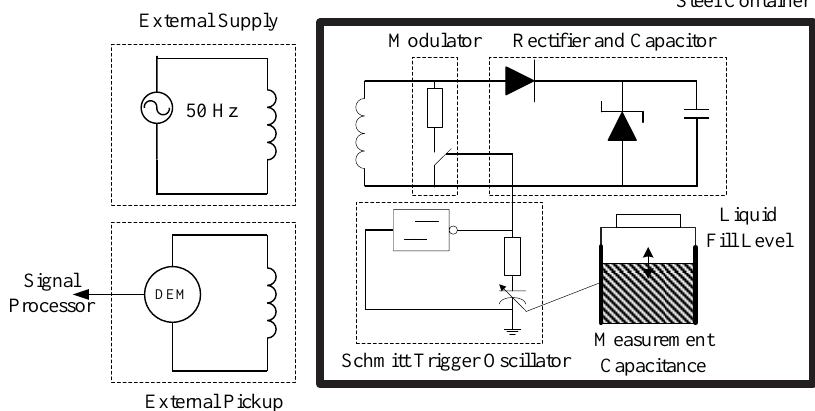
Figure 2. Diagram of power delivery and data transmission for an fill level capacitive sensor electronics enclosed in a metal container, redrawn from Zangl et al. [8].